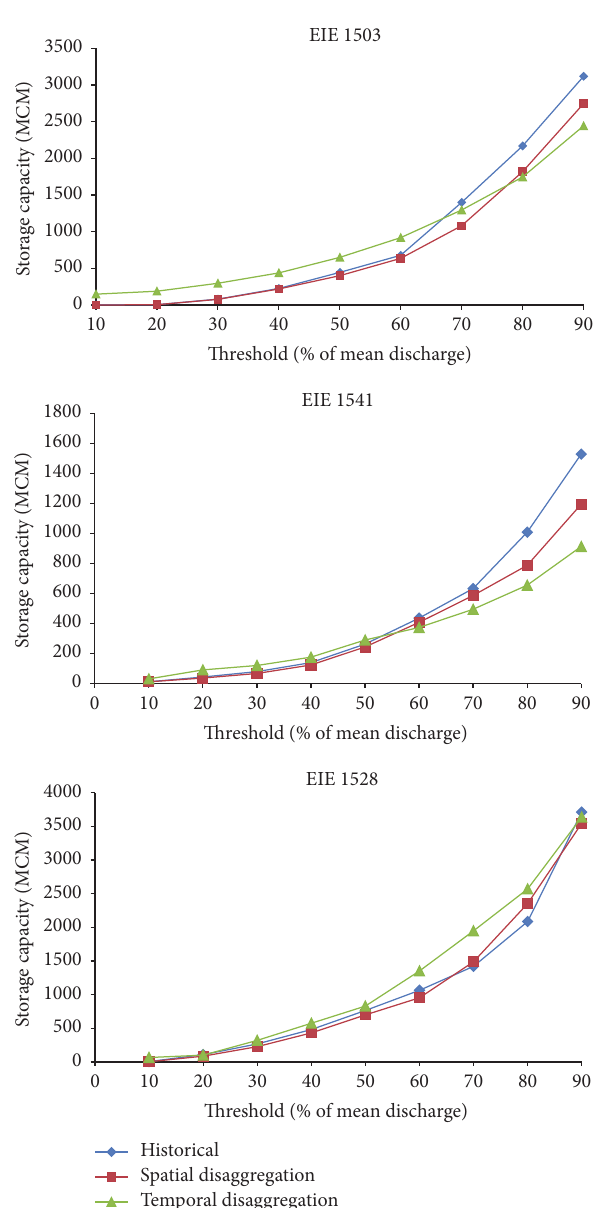
Figure 13: Monthly storage capacity calculated using historical flow and data generated by spatial and temporal disaggregation approaches in all